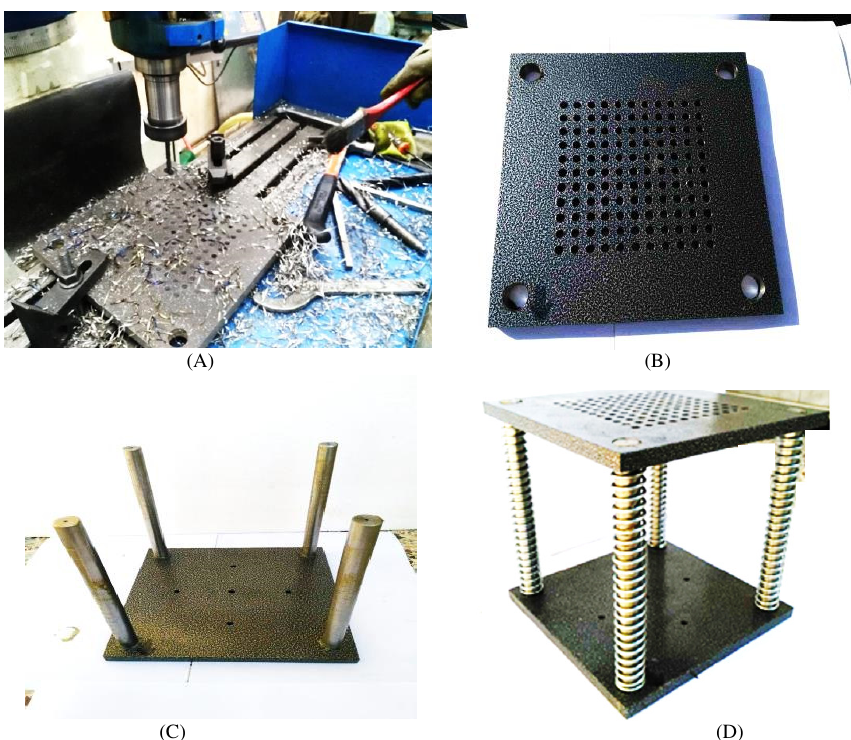
Fig. 8. Stages of die manufacturing, (A,B) upper plate ,(C) lower plate and guides and (D) forming die after assembly upper plate, lower plate and guides.